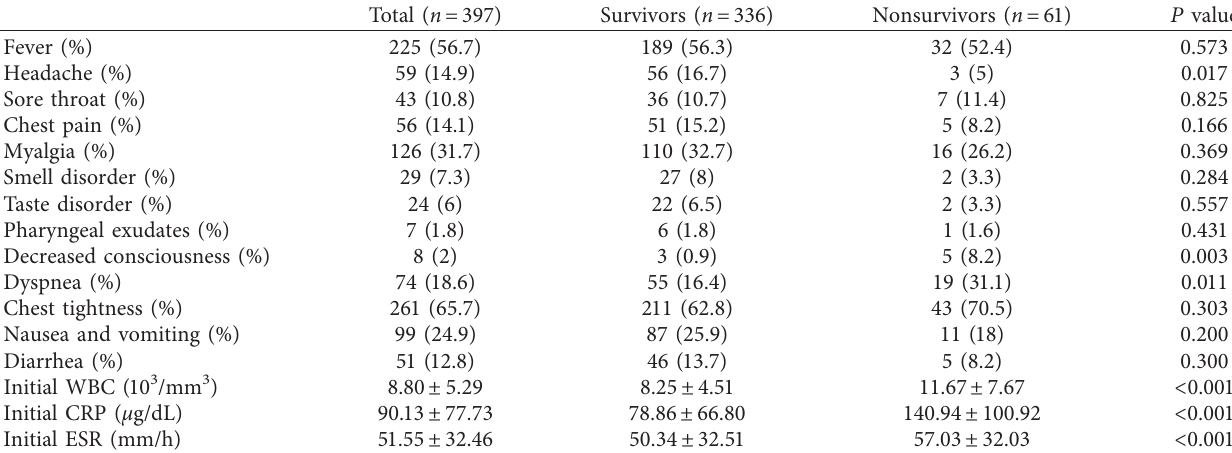
Table 2: Baseline clinical manifestations and laboratory findings of survivors and nonsurvivors of COVID-19.